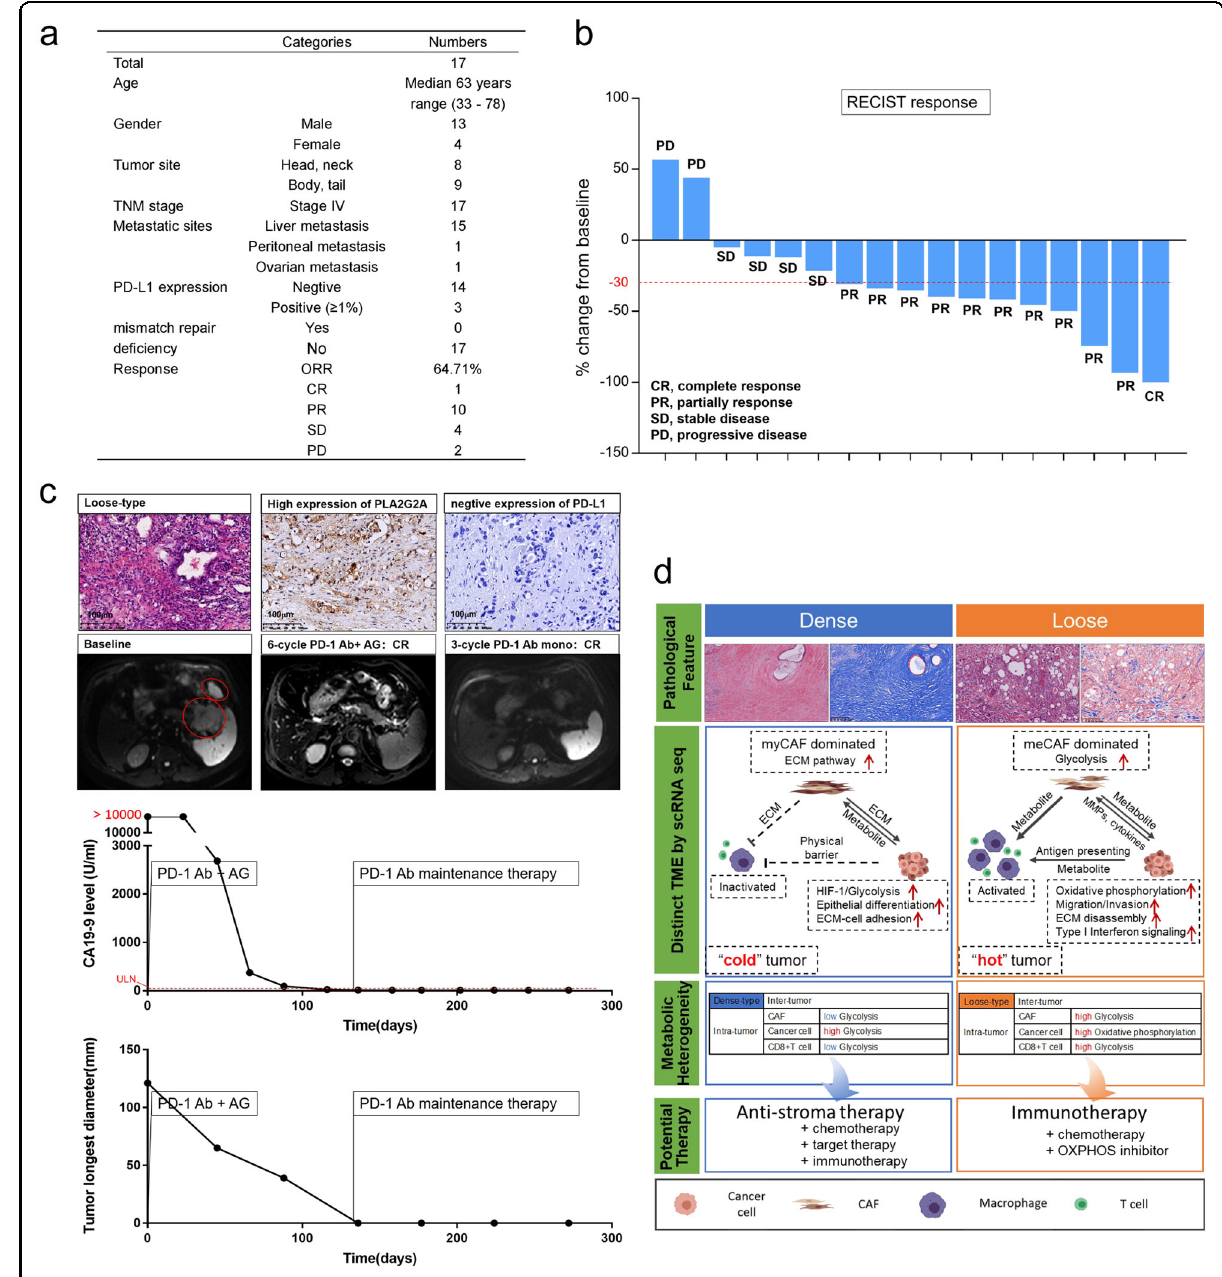
Fig. 5 High abundance of meCAFs is correlated with a better response to immunotherapy in patients with PDAC. a Clinical characteristic of 17 PDAC patients with abundant meCAFs included in our study. b Response evaluation of the 17 PDAC patients receiving 6 cycles of chemotherapy (gemcitabine plus albumin-bound paclitaxel) combined with PD-1 antibody (10 partial responses, 1 complete response, objective response rate: 64.71%). c The response of a representative loose-type PDAC patient after receiving chemotherapy combined with PD-1 antibody treatment and PD- 1 antibody alone. H&E and IHC stainings of PLA2G2A and PD-L1 were examined. Follow-up clinical indicators including MRI and serum CA-199 after treatment are shown. CR, complete response; AG, gemcitabine plus albumin-bound paclitaxel; ULN, upper limit of normal. d Schematic diagram summarizing the intertumoral heterogeneity of cellular components, function and metabolism in dense- and loose-type PDACs, suggesting potential clinical signi fi cance and therapeutic